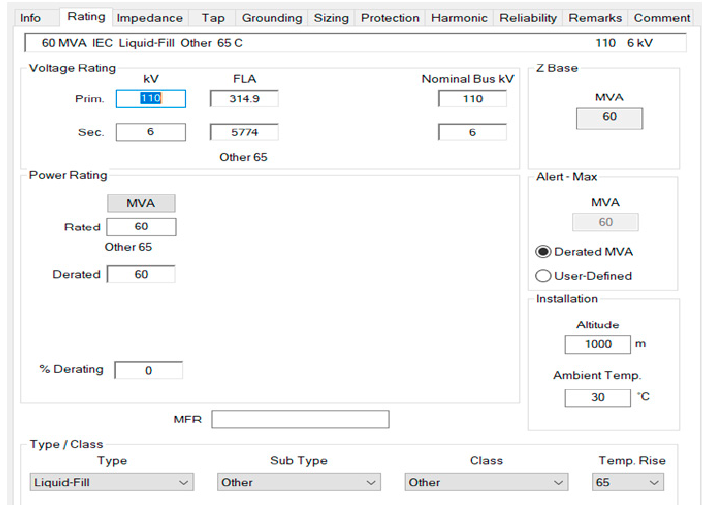
Figure 5. The nominal data for T1.